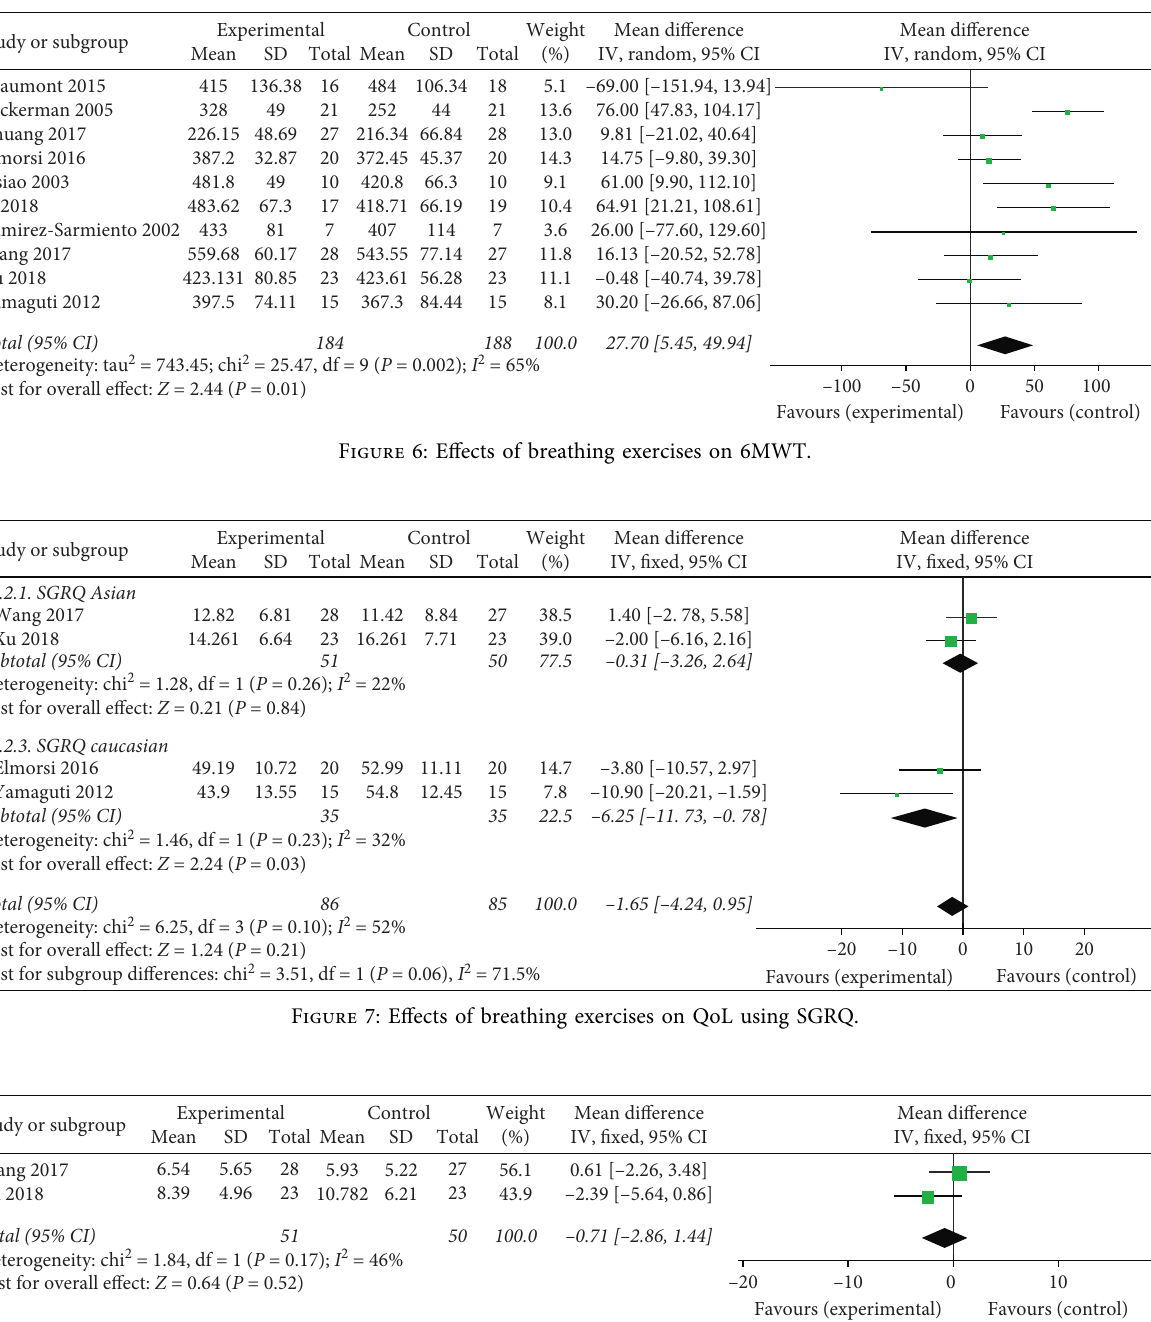
Figure 8: Effects of breathing exercises on QoL using CAT.